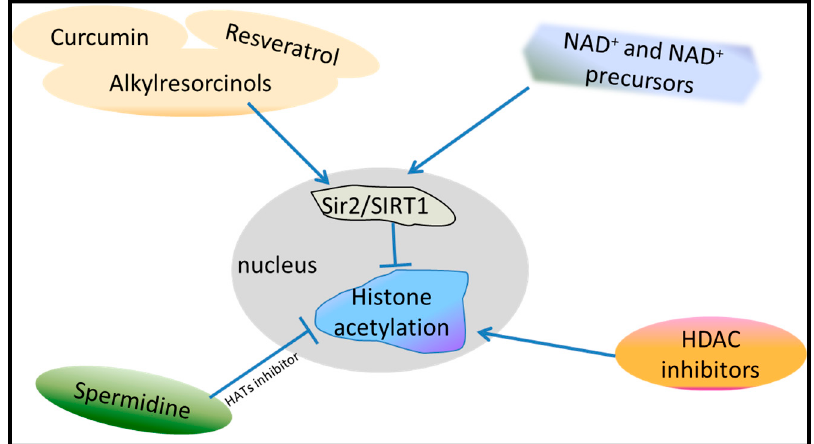
Figure 4. Epigenetic targets for pharmacological manipulation. Histone acetylation results in a more open chromatin state and greater access of DNA to transcription factors, leading to genome instability. Sir2/SIRT1 activators, such as curcumin, resveratrol and alkylresorcinols, can activate the sir2/SIRT1 activity to promote deacetylation. NAD+ and NAD+ precursors can also target sir2/SIRT1 to stimulate deacetylation. Spermidine, as a histone acetyltransferase (HAT) inhibitor, can suppress histone acetylation. Histone deacetylase (HDAC) inhibitors can promote histone acetylation.